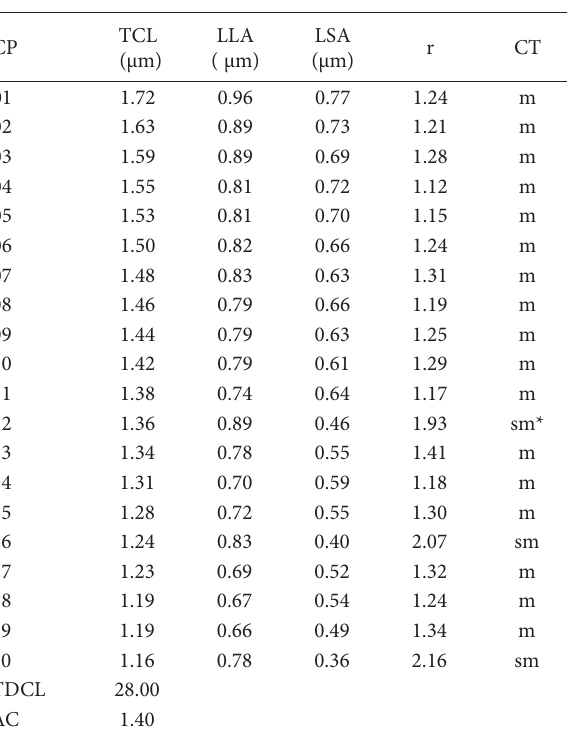
Table 1. Average chromosome measurements obtained from five + 6sm) under